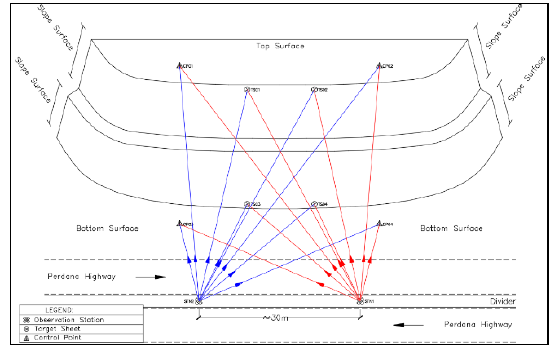
The procedure of